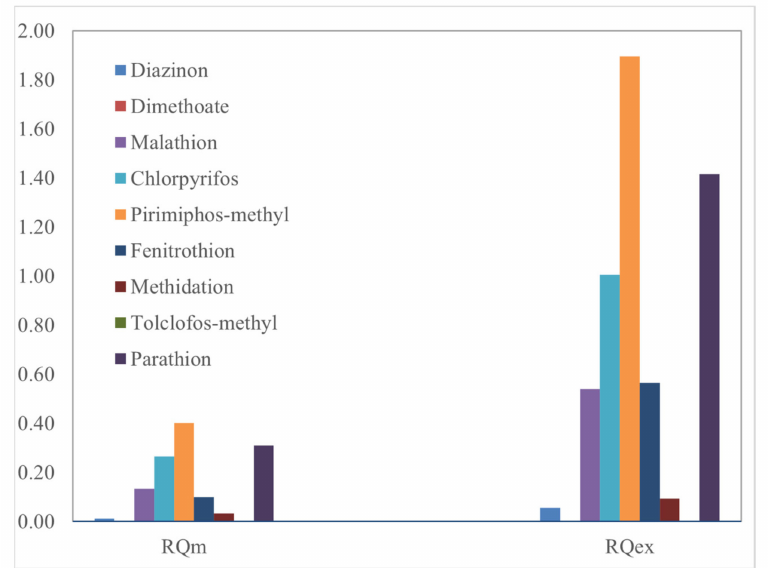
Figure 8. Risk quotients ( RQ m and RQ ex ) of the detected OPPs in the water (WDP+SPM) of the Sele River estuary, Southern